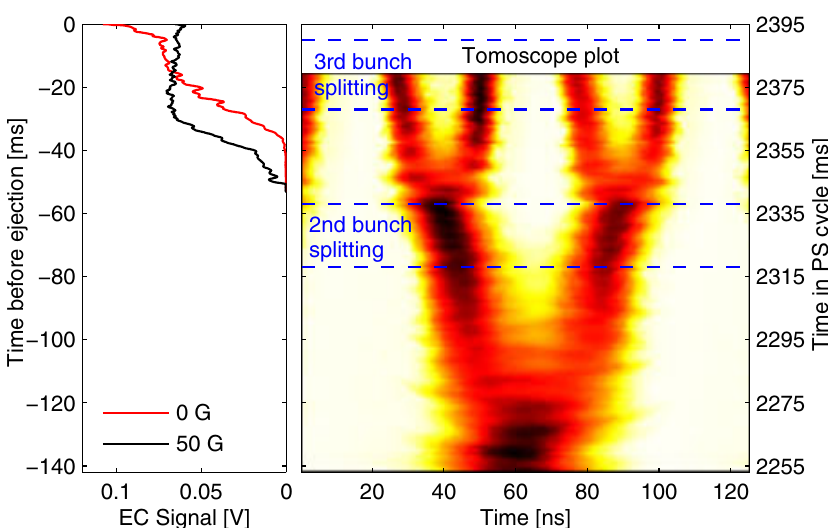
FIG. 7. (Color) The EC signal (left) compared with the bunch length during the rf gymnastics represented in a tomoscope plot (right, courtesy of Steven Hancock.). The EC buildup starts 40 to 50 ms before ejection, right after the second bunch splitting.